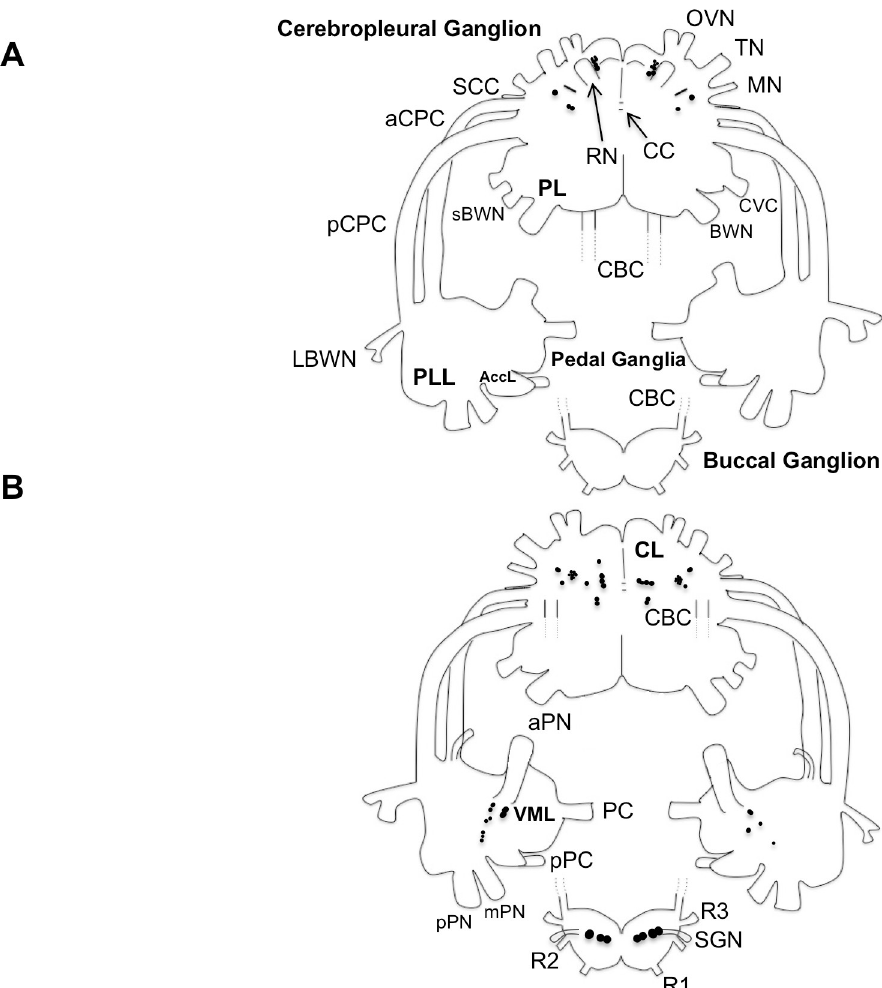
Fig 2. Summary diagram of the distribution of tyrosine hydroxylase-like immunoreactive neurons in the central nervous system. Somata are indicated as black circles on the dorsal (A) and ventral (B) surfaces of the cerebropleural, pedal, and buccal ganglia (modified from [38]; cells not drawn to scale). The cerebrobuccal connectives (CBC) are shown cut here for clarity. Cerebropleural ganglion abbreviations: aCPC, anterior cerebropedal connective; BWN, body wall nerve; CBC, cerebrobuccal connective; CC, cerebral commissure; CL, cerebral lobe; CVC, cerebrovisceral connective; MN, mouth nerve; OVN, oral veil nerve; PL, pleural lobe; pCPC, posterior cerebropedal connective; RN, rhinophore nerve; sBWN, small body wall nerve; SCC, subcerebral commissure; TN, tentacle nerve. Pedal ganglia abbreviations: AccL, accessory lobe; LBWN, lateral body wall nerve; pPC, parapedal commissure; PC, pedal commissure; PLL, posterior lateral lobe; pPN, posterior pedal nerve; VML, ventromedial lobe. Buccal ganglion abbreviations: R1-R3, buccal roots 1–3; SGN, stomatogastric nerve.